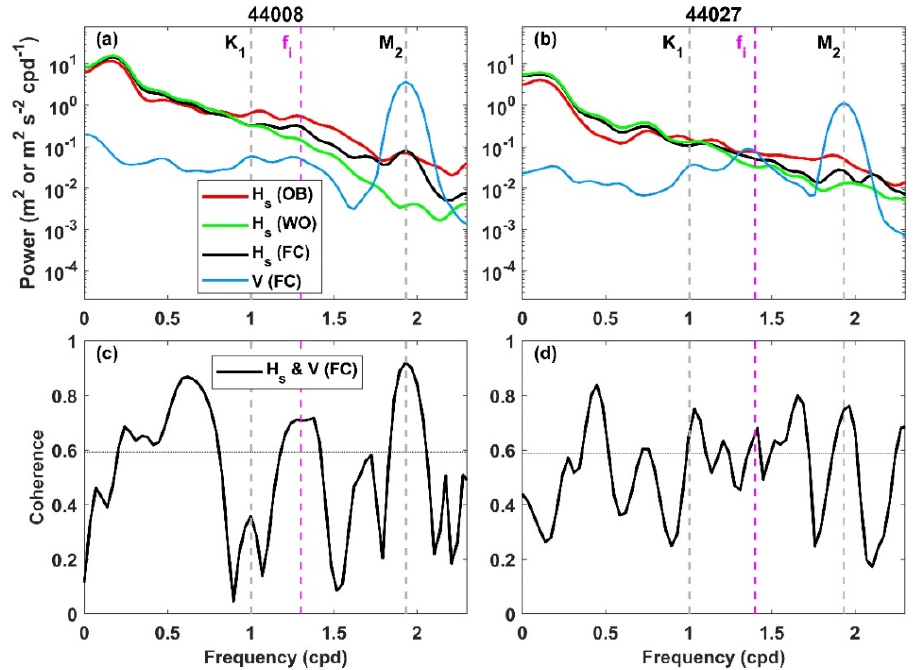
Figure 6. Power spectra of time series of the SWHs ( H s ) and depth-weighted meridional currents ( V ) at buoy ( a ) 44008 and ( b ) 44027 and the corresponding ( c , d ) coherence spectra between H s and V . Dotted lines denote the 5% significance level for zero coherence.